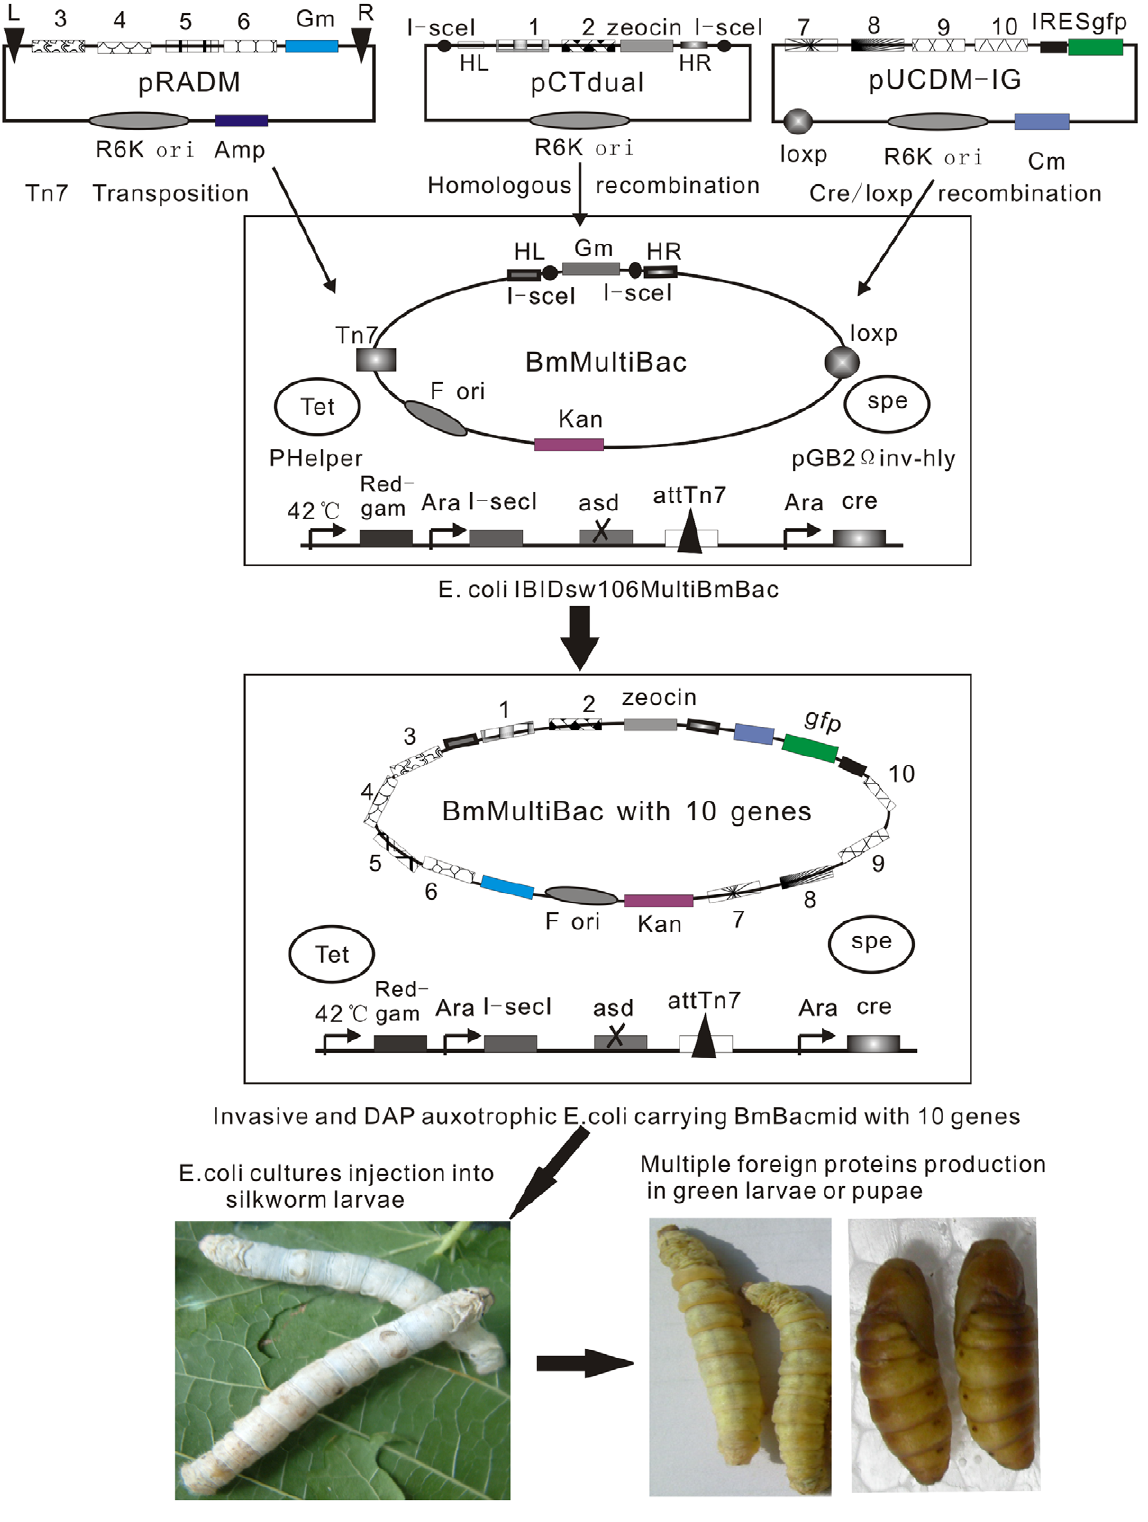
Figure 1. The flowchart of producing infective BmNPV expressing ten heterologous genes in silkworm larvae or pupae. The target genes are cloned into the three donor vector (pCTdual, pRADM and pUCDMIG) using usual method. The first two genes carried by pCTdual are inserted into BmBacmid through I-Sce I linearization and red-gam homologous recombination. Four genes in pRADM and the other four genes in pUCDMIG are then introduced into BmBacmid via Tn7 transposition and cre-loxp recombination, respectively. As a result, ten foreign expression cassettes and three antibiotic screening markers, as well as a GFP illumination marker are introduced into BmBacmid. The invasive and DAP auxotrophic E. coli carrying recombinant BmBacmid are injected into silkworm larvae at an appropriate dose. Consequently, recombinant BmNPV will be produced and multiple foreign genes will be expressed in green B. mori larvae or pupae. doi:10.1371/journal.pone.0032510.g001 PLoS ONE |